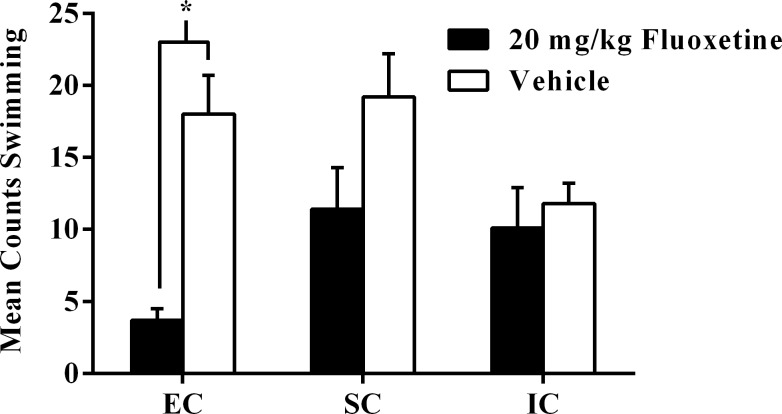
Experiment II Forced Swim Test Swimming Behavior Experiment II total mean counts (±SEM) of swimming behavior between EC, SC, and IC rats after subchronic fluoxetine (20 mg/kg, i.p.) or vehicle administrations before the FST.Asterisk (*) indicates EC rats receiving fluoxetine exhibited significantly less swimming than EC rats receiving vehicle injections (p < .05).